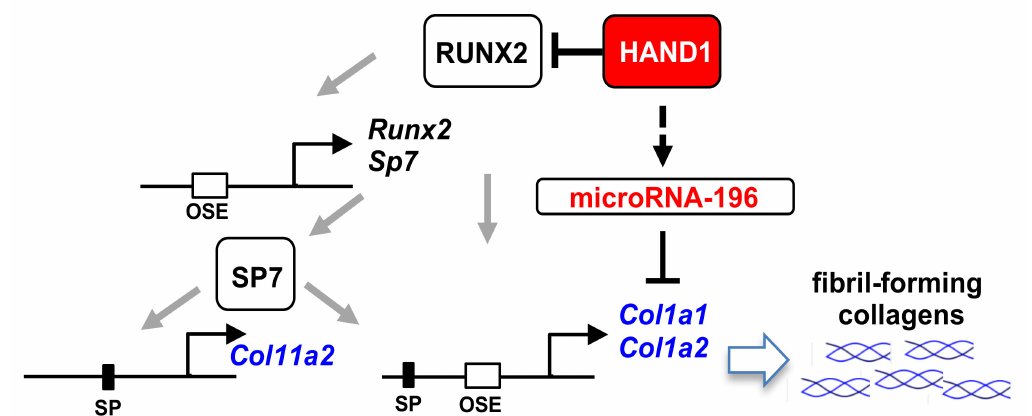
Figure 5. A predictive model for HAND1-mediated regulation of bone-related collagen expression. Expression of fibril-forming collagen genes (shown in blue) is decreased in the cortical bones of Hand1 -overexpressing mice during postnatal development. HAND1 regulates osteoblast di ff erentiation by inhibiting the transactivation of RUNX2 [25,27]. RUNX2 binds its own promoter and establishes a positive autoregulatory loop [44]. RUNX2 also acts upstream of Col1a1, Col1a2 , and Sp7 / Osterix . SP7 / Osterix in turn directly upregulates Col1a1, Col1a2, and Col11a2 by binding to Sp1 sites [18–21,45,46]. The expression levels of members of miR-196 family, which target the 3 (cid:48) UTR of Col1a1 and Col1a2 [42], are upregulated in Hand1 -overexpressing mice. OSE, RUNX2-binding site; SP, Sp1 binding